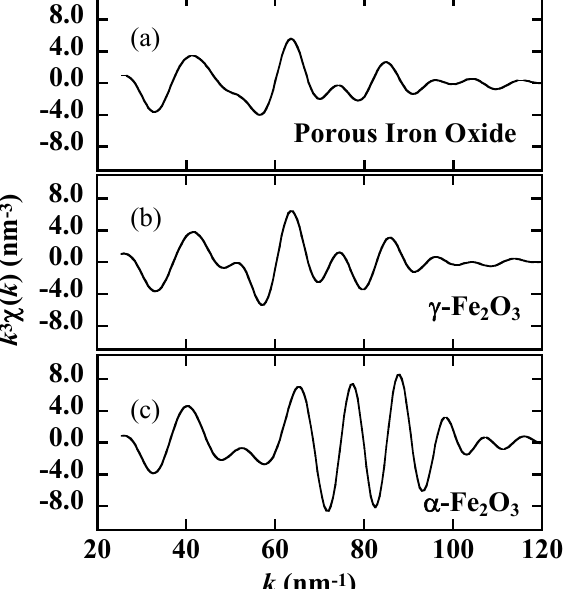
Figure 6. EXAFS spectra at Fe K absorption edge of (a) large porous iron oxide particles obtained from phos- phosiderite by alkaline treatment, (b) (cid:2) -Fe 2 O 3 particles prepared from (cid:2) -FeOOH, and (c) reference ˛ -Fe 2 O 3 parti- cles.